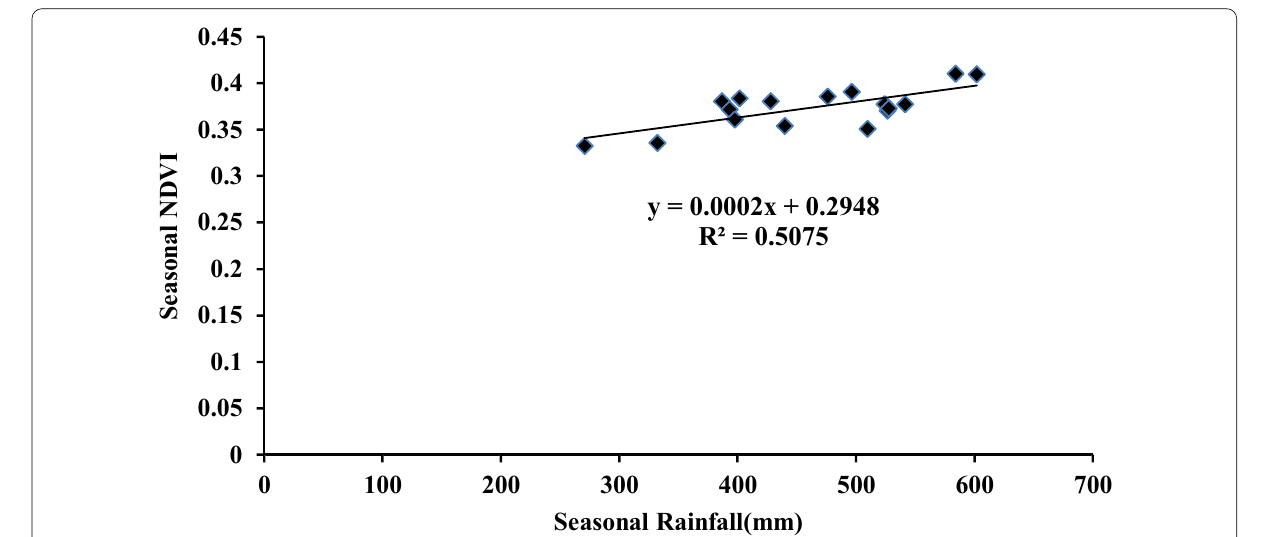
y = 0.0002x + 0.2948